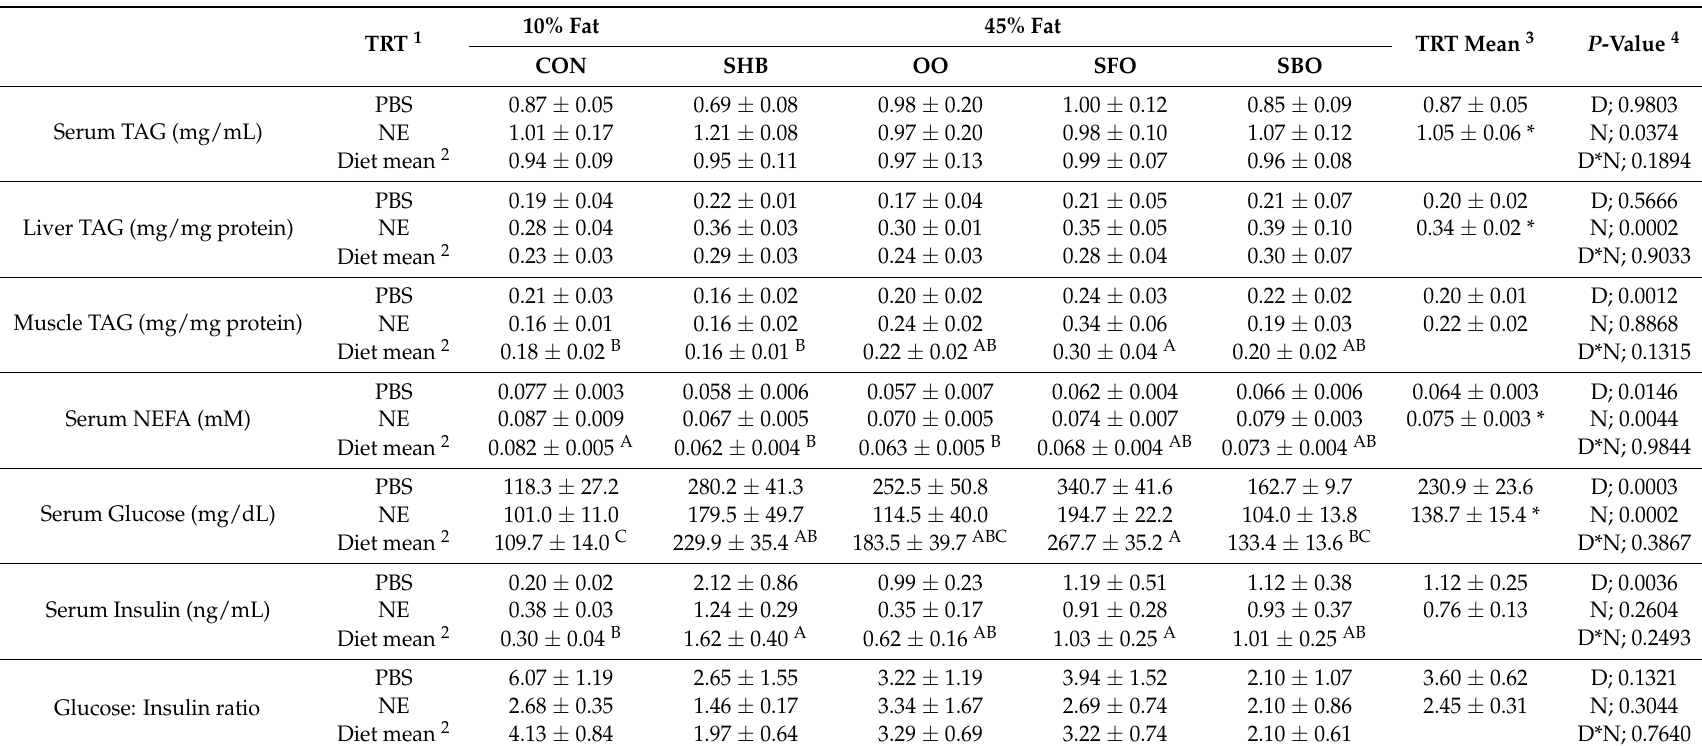
Table 3. Lipid, Glucose, and Insulin